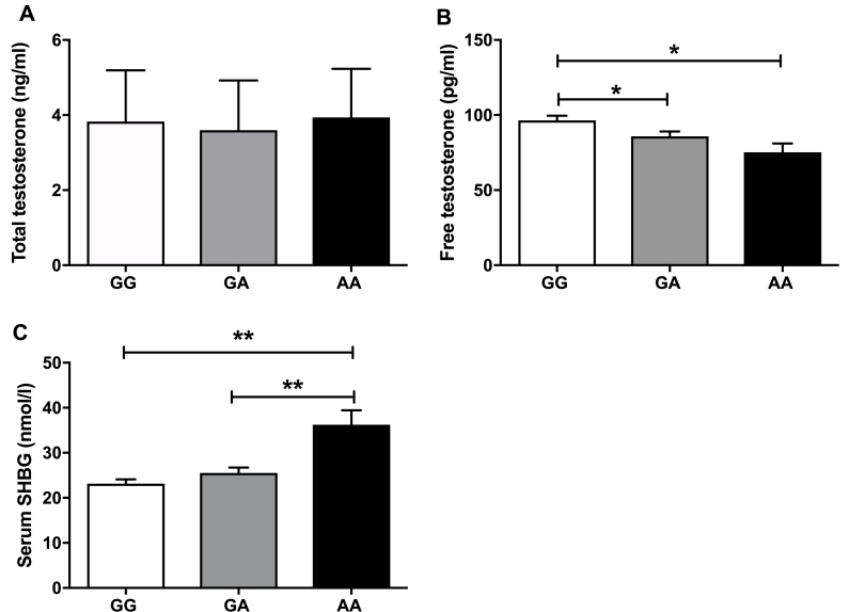
Figure 1. ( A ) The mean of the total testosterone levels across each SHBG polymorphism. ( B , C ) The mean distribution of free testosterone and serum SHBG for each and every study genotype. * means p < 0.05 and ** means p < 0.01 according to Kruskal – Wallis statistics followed by a Mann – Whitney U test for the group by group